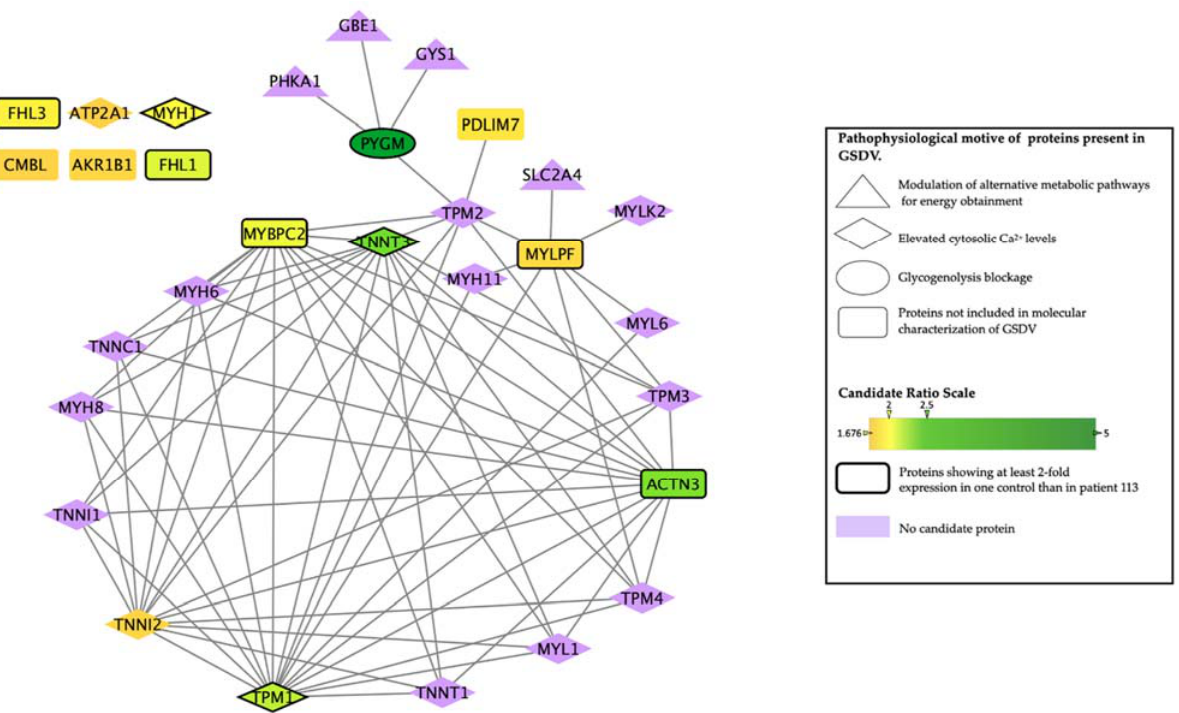
Figure 1. Interactome network map between the most differentially expressed proteins and the genes of GSDV effectors. The figure shows the most differentially expressed proteins and their internal relationships, as well as the relationships with the GSDV effectors. Symbols indicate whether the protein is included as an effector of each GSDV pathophysiological motif. The most differentially expressed proteins are highlighted according to a colored gradient showing the control/patient values ratio. Proteins with expression levels at least two-fold higher in one control than in patient 113 (i.e., 114/113 or 116/113 values) are marked by a thick border in the corresponding symbol. GSDV effectors not detected within the most differentially expressed proteins are depicted in purple color.